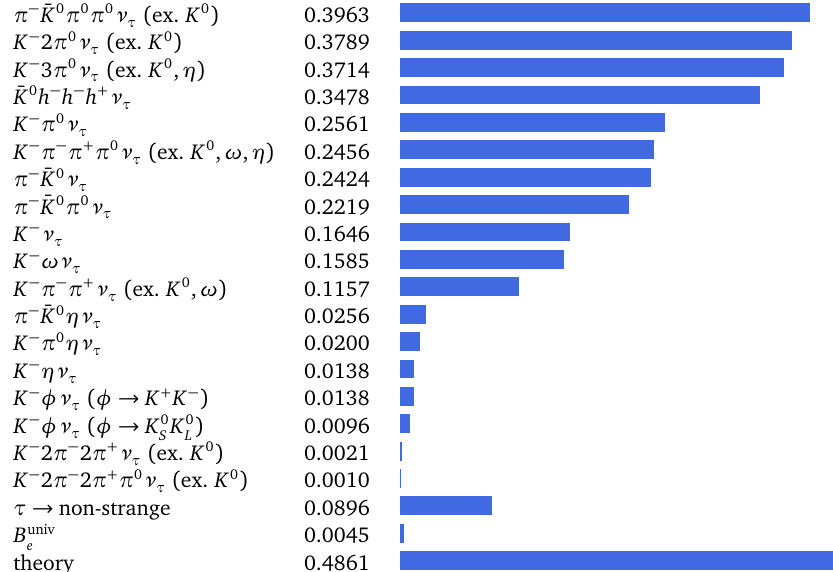
| τ s uncertainty in percent before the B A B AR 2018 us